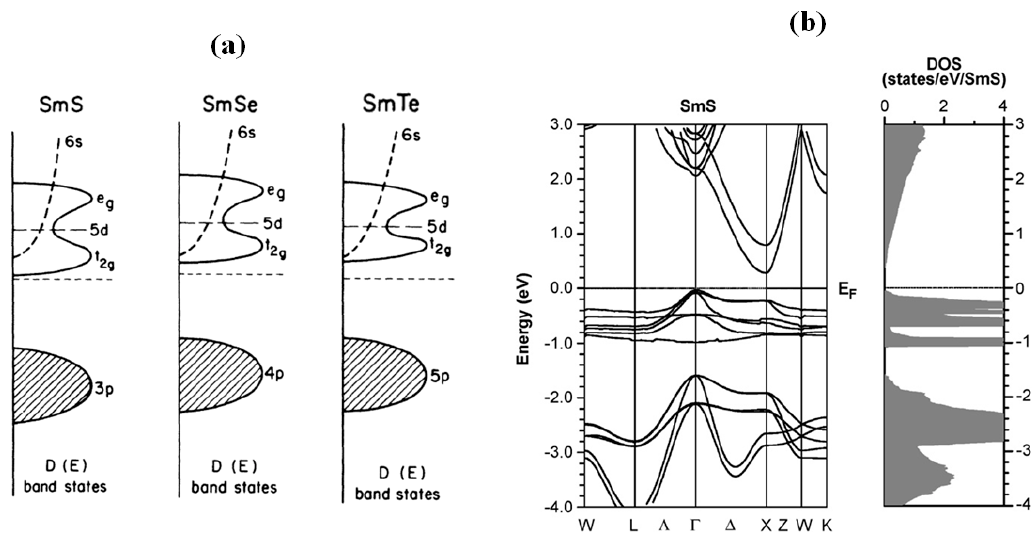
Figure 2. ( a ) Band structures for semiconducting monochalcogenides SmS, SmSe and SmTe, where D(E) is the density of states. For these cases, the gap between occupied and unoccupied states is different according to Batlogg, with the 4f 5 state fully occupied; ( b ) Band structure from computational work, in the semiconducting state following the LSDA+U (Coulomb repulsion energy of Sm 4f) method with the contribution of spin-orbit coupling. (Reprinted with permission from [30] and [34], respectively.)